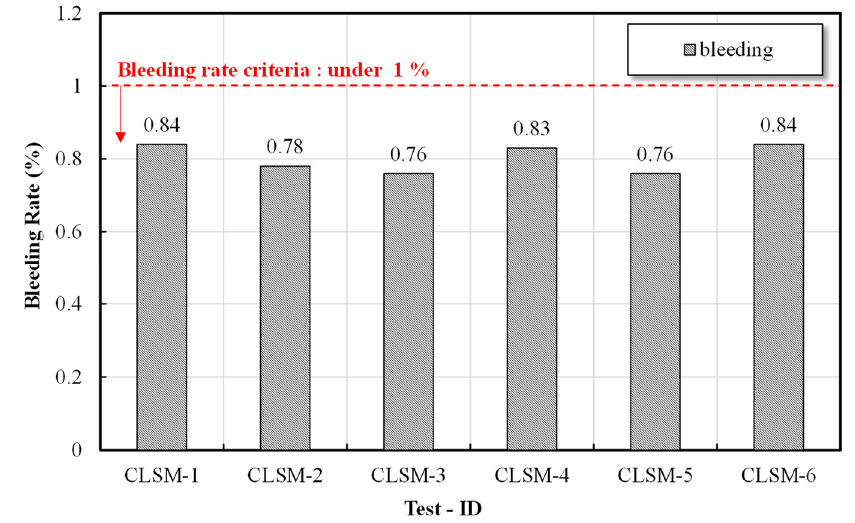
Figure 4. Material separation resistance test results based on the